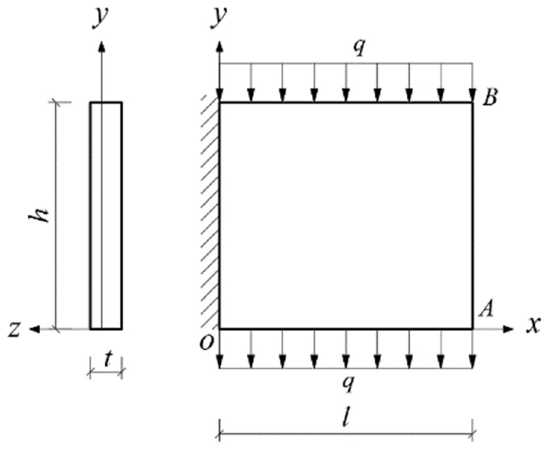
Figure 5. Bimodular rectangular plate with top and bottom loaded.